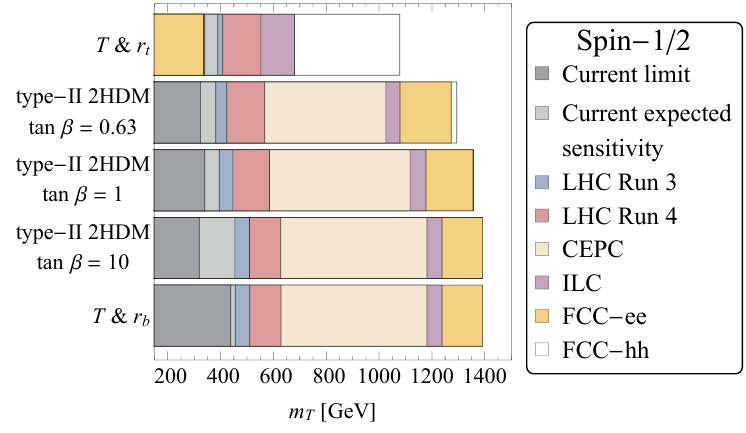
Figure 9 . Excluded parameter space at 2 (cid:27) C.L. on spin-1/2 top-partner mass, m 2HDM with various tan (cid:12) of current and future data (various colors). In the plots, we again show the (non-2HDM) \ T & r t " and \ T & r b " scenarios from (cid:12)gure 6 for ease of comparison.